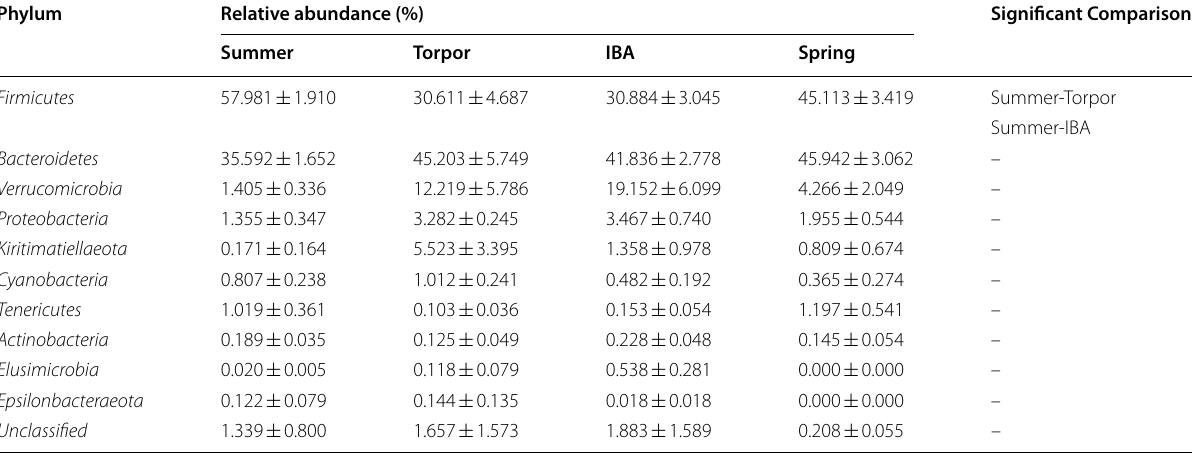
Phyla have total relative abundances > 1% and are displayed from overall highest relative abundance to lowest relative abundance. Relative abundances are displayed as mean standard error. Significant comparisons had adjusted p -values < 0.05 based on ANOVA and Tukey’s HSD tests, or had adjusted p -values < 0.025 based on ± Kruskal–Wallis and Dunn’s Tests, depending on data normality